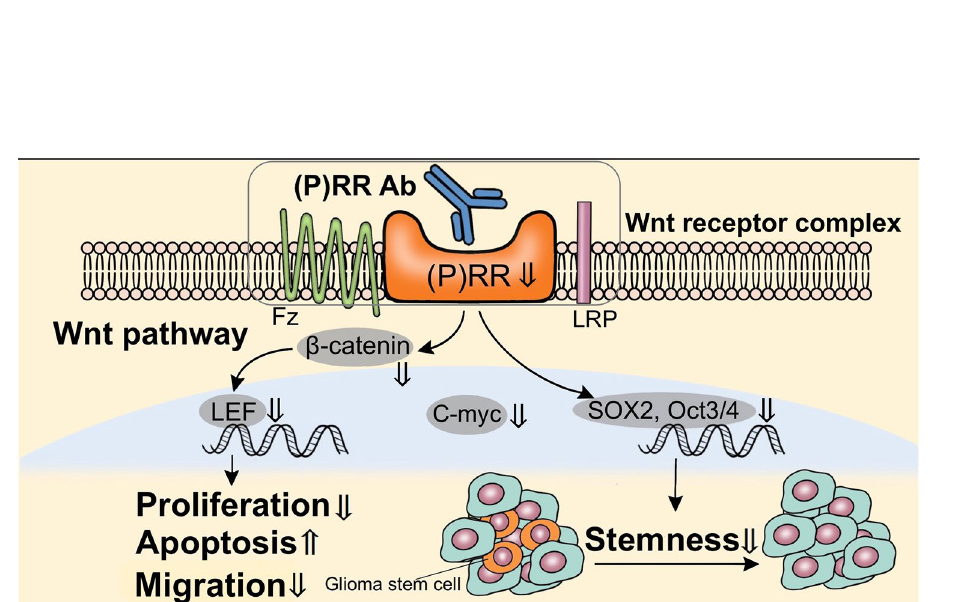
Figure 7. Proposed model for the effect of the (P)RR Ab in glioblastoma. Treatment with the (P)RR Ab decreases cell proliferation and migration and induces apoptosis via inhibition of the Wnt signaling pathway. The (P)RR Ab suppresses SOX2 and Oct3/4 expression and cell proliferation of the glioma stem cell line, which indicates that the (P)RR Ab inhibits stemness of glioma. Fz